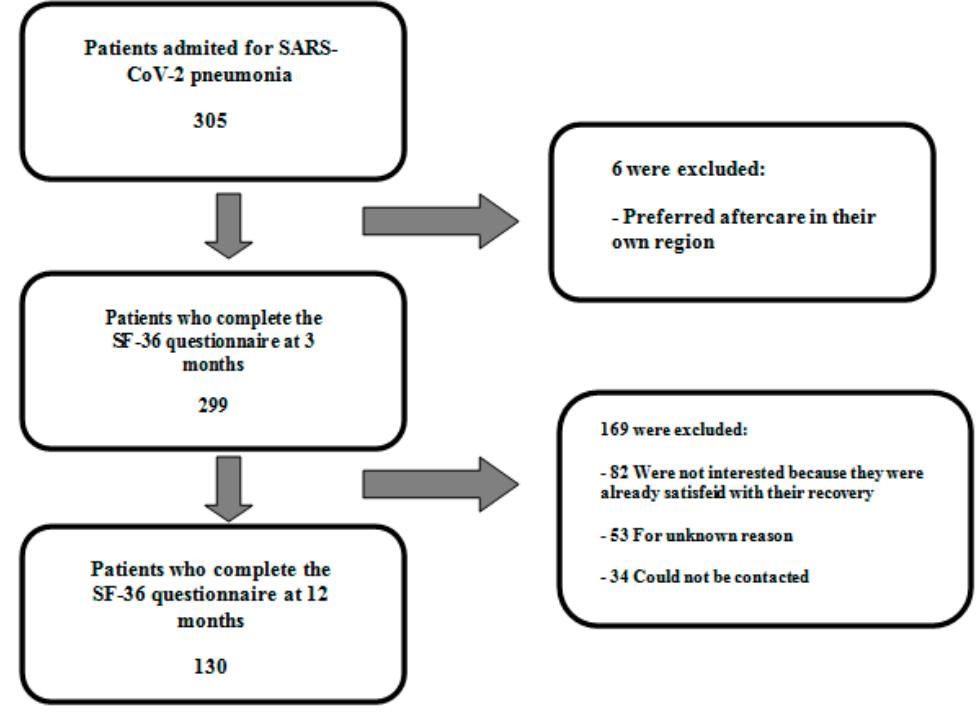
Figure 1. Flow chart of patient inclusion.